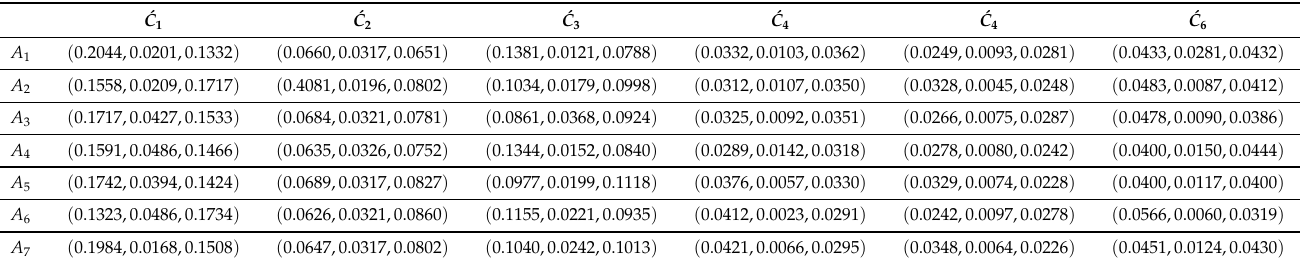
Table 17. Weighted decision matrix.